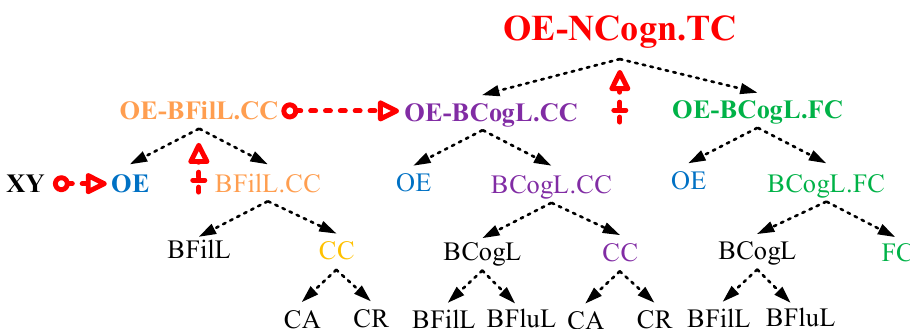
Figure 13. Taxonomy of the couplings of routing algorithms and traffic control schemes evaluated in experiments.